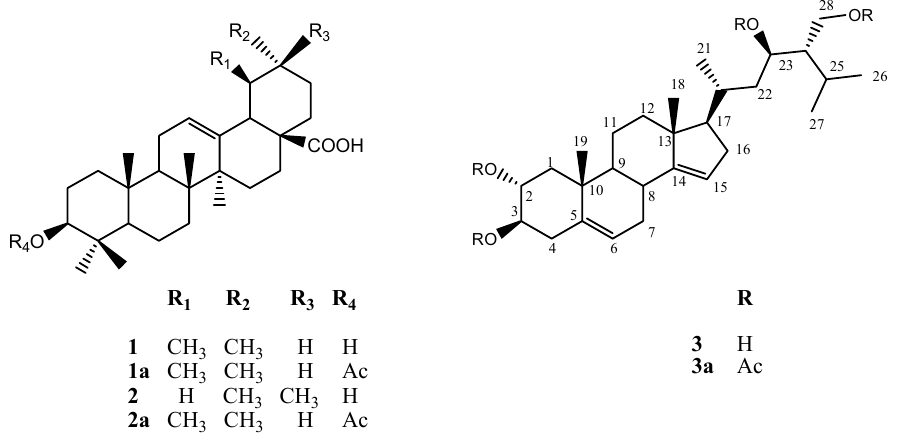
Figure 4. Chemical structure of compounds 1 , 1a , 2 , 2a , 3 and 3a isolated from line LRT 7.31 hairy roots of L. racemosa .